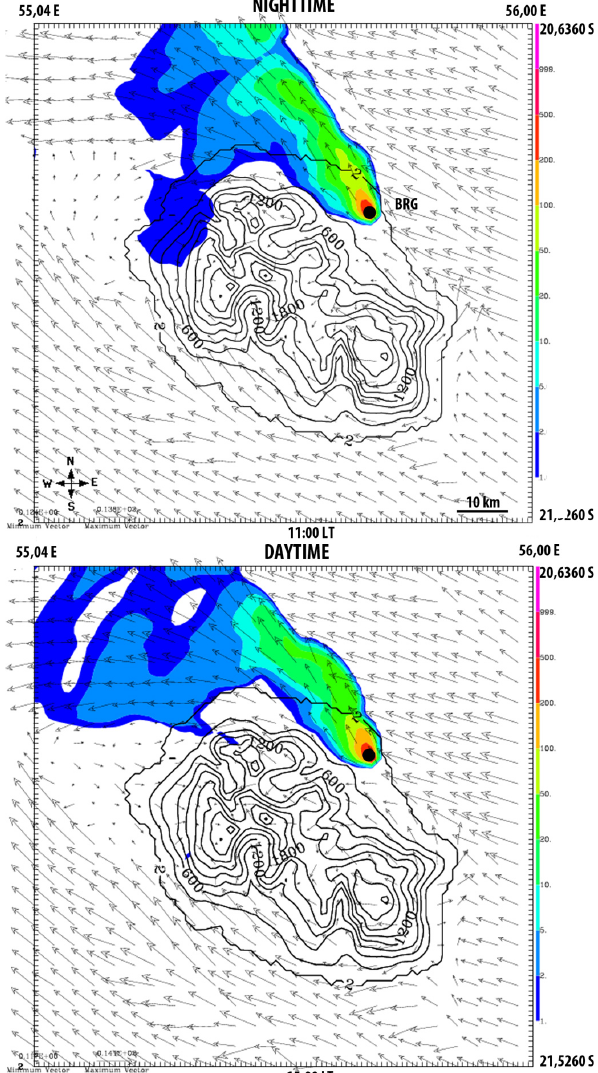
Fig. 15. ALIZ10 – horizontal field of the tracer dilution ratio (per mil of the concentration at emission point) at the first model level above the ground, emitted from DEN, at 07:00LT (top) and 16:00LT